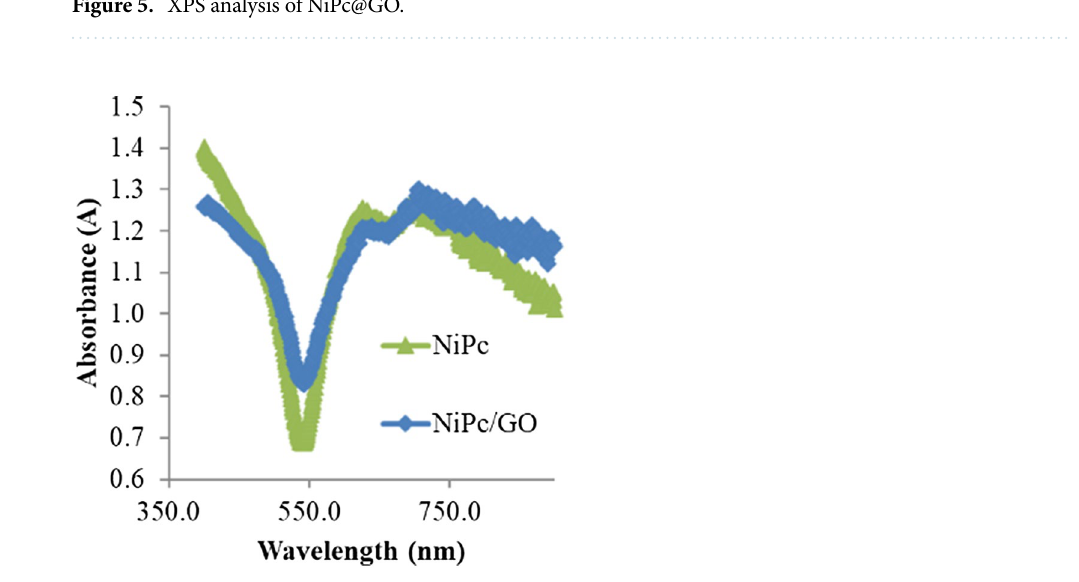
Figure 5. XPS analysis of NiPc@GO.